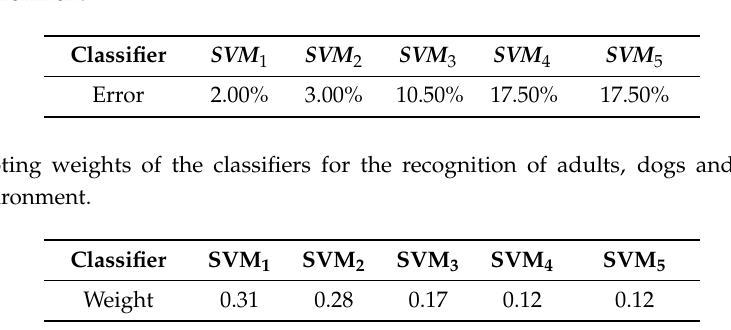
Table 6. Classification errors of the classifiers for the recognition of adults, dogs and geese in the outdoor environment.